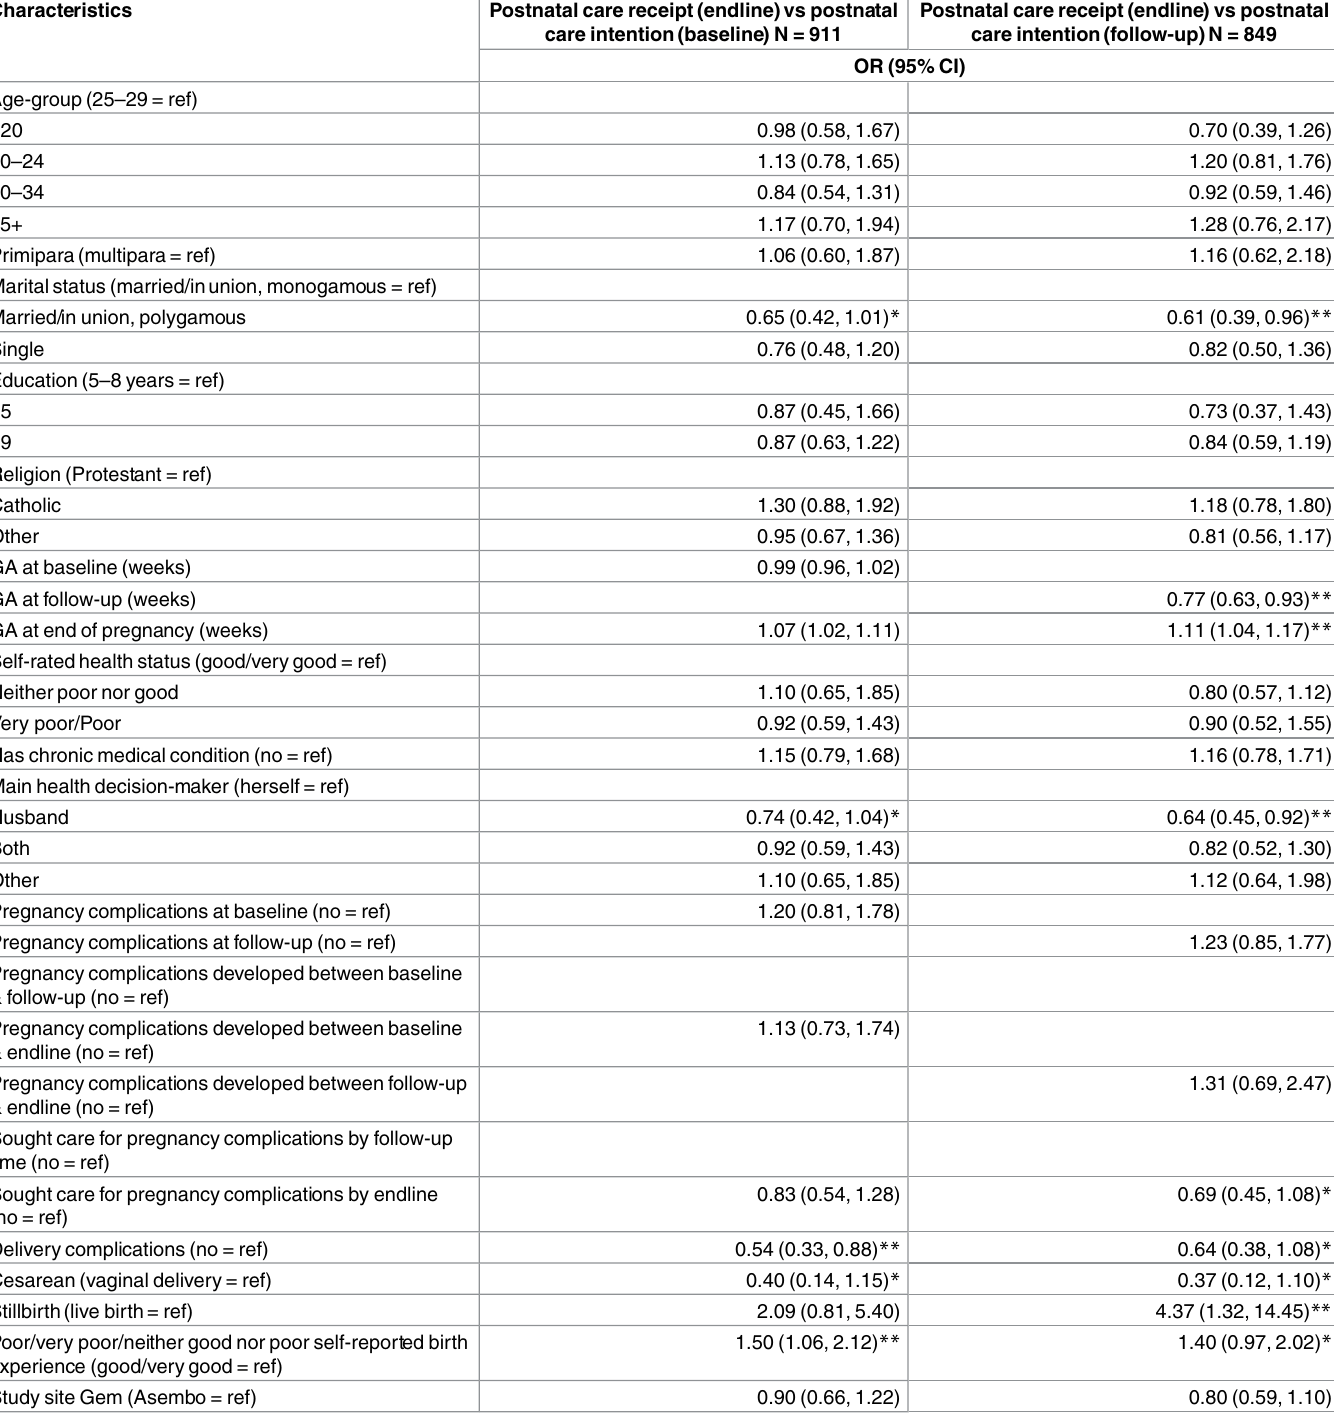
Table 3. Predictorsof discordance betweenwomen’s intentionsand behaviors regardingpostnatalcare: Kenya, 2013.